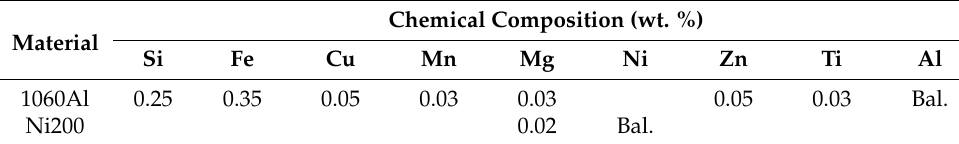
Table 1. Chemical composition of two welding materials.